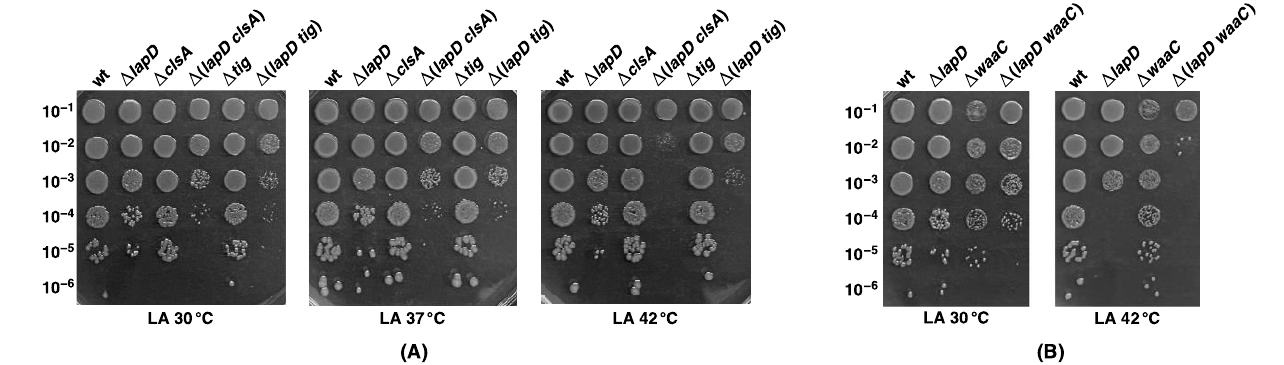
Figure 8. The conditional synthetic lethal phenotype of various mutational combinations reflecting the essentiality of the lapD gene when either the LPS is truncated or cardiolipin biosynthesis is disrupted or when the PPIase activity is impaired. Growth of isogenic cultures of strains of wild type, Δ lapD , Δ clsA , Δ waaC , Δ tig and various null combinations was quantified by spot dilution on LA at different temperatures (Panels A and B ). The relevant genotype and temperature of incubation are indicated.